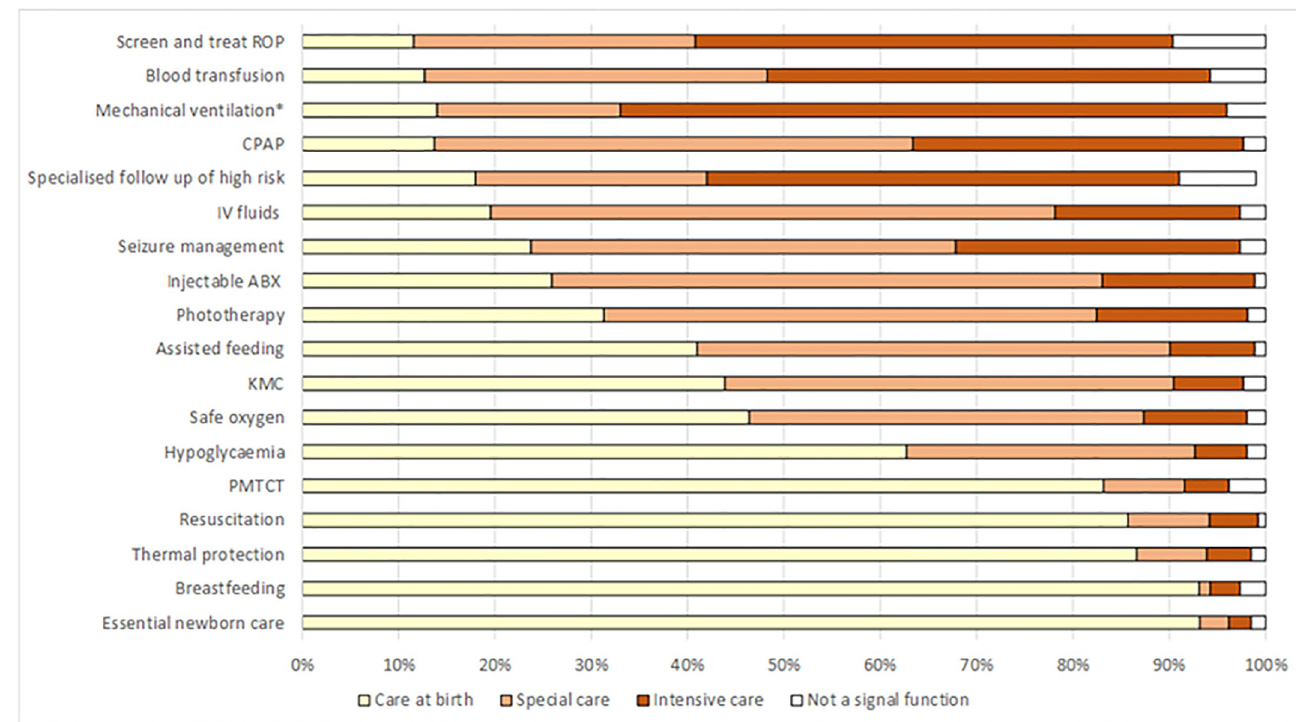
Fig 2. Bar graph showing list of interventions and percent of respondents for each level of care (n = 262). PMTCT = Prevention of mother to child transmission of HIV, KMC = Kangaroo mother care, ABX = antibiotics, IV = intravenous, CPAP = Continuous positive airway pressure, ROP = retinopathy of prematurity. � Only intervention classified by > 50% of respondents as “intensive